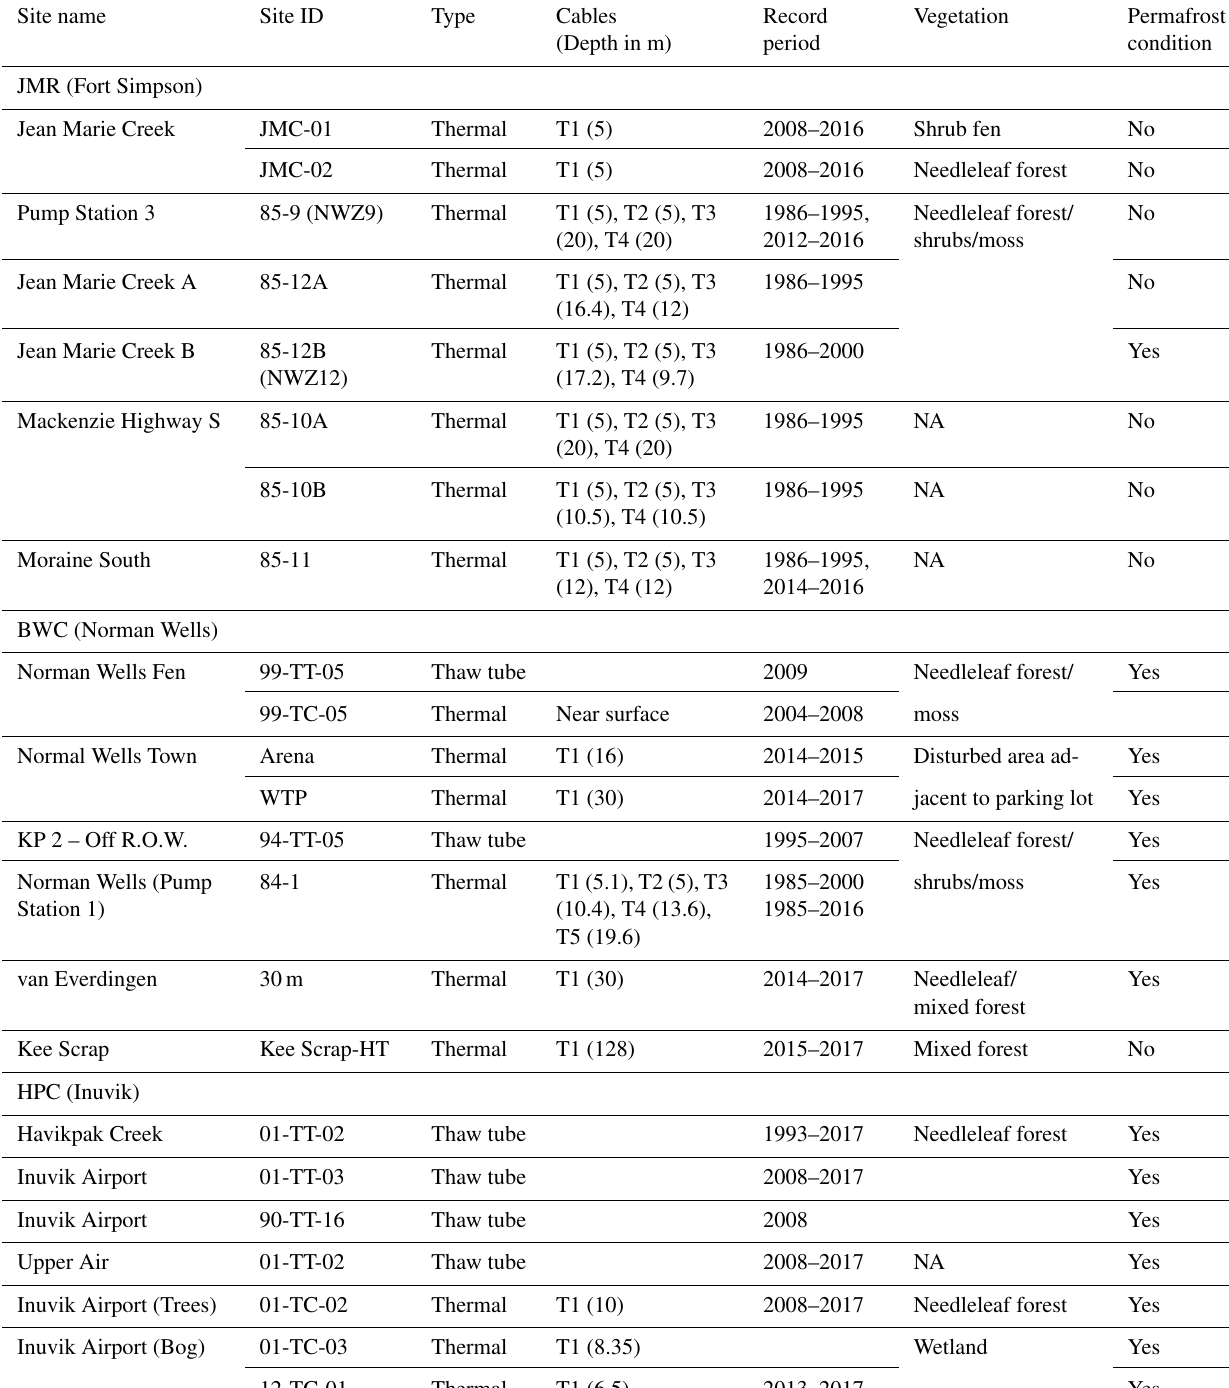
Table 1. Permafrost sites and important measurements for the study sites. NA: not available. KP: kilometre post (distance from the start of the pipeline in Norman Wells). R.O.W.: right-of-way (of the